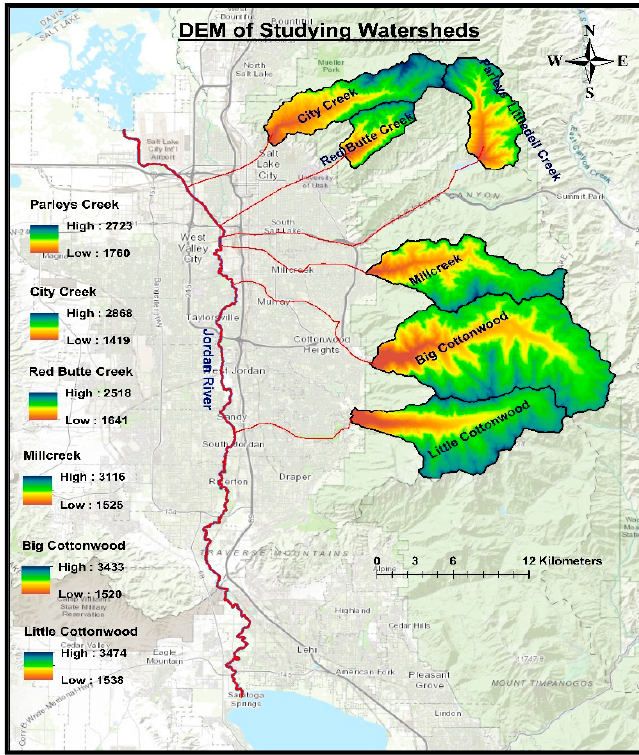
Figure 2. DEM of the six studied watersheds.